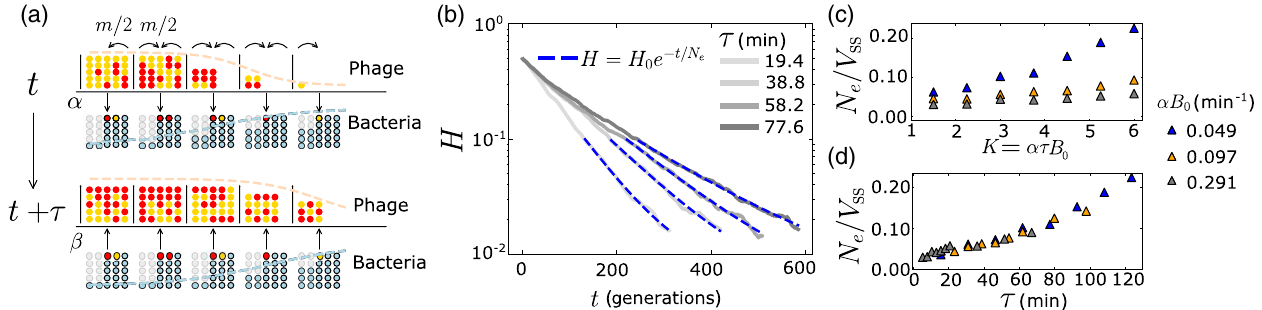
FIG. 6. (a) Simulation algorithm of stochastic simulations of plaque growth. Each deme contains two labeled phage populations (yellow and red circles) and bacteria that can be dead (gray), uninfected (light blue), or infected with one type of phage (red or yellow). At each step, phage can migrate to neighboring demes with probability m= 2 (right or left curved arrows), infect an uninfected cell with probability α (downward arrow), and after τ time steps introduce β phage into the deme upon cell lysis (upward arrow). Dashed lines indicate the analogous density profile similar to those shown in Fig. 2(a). (b) Example of linear fit to log-transformed heterozygosity data shown for α B 0 ¼ 0 . 077 min − 1 , B 0 ¼ 100 cells/deme, and a range of τ values. Heterozygosity data represent the average of approximately 1000 simulations. Slope of fit 1 =N e is the calculated decay rate for the given parameter values. (c),(d) Effective as a function of K (c) and τ population size N e for B 0 ¼ 75 normalized by the steady-state population in the bulk of the population V SS (d) over a range that could be expected in various viral populations. Colors indicate specific values of α B 0 . Errors in (c) and (d) due to linear fit of heterozygosity decay over time are negligibly small and not